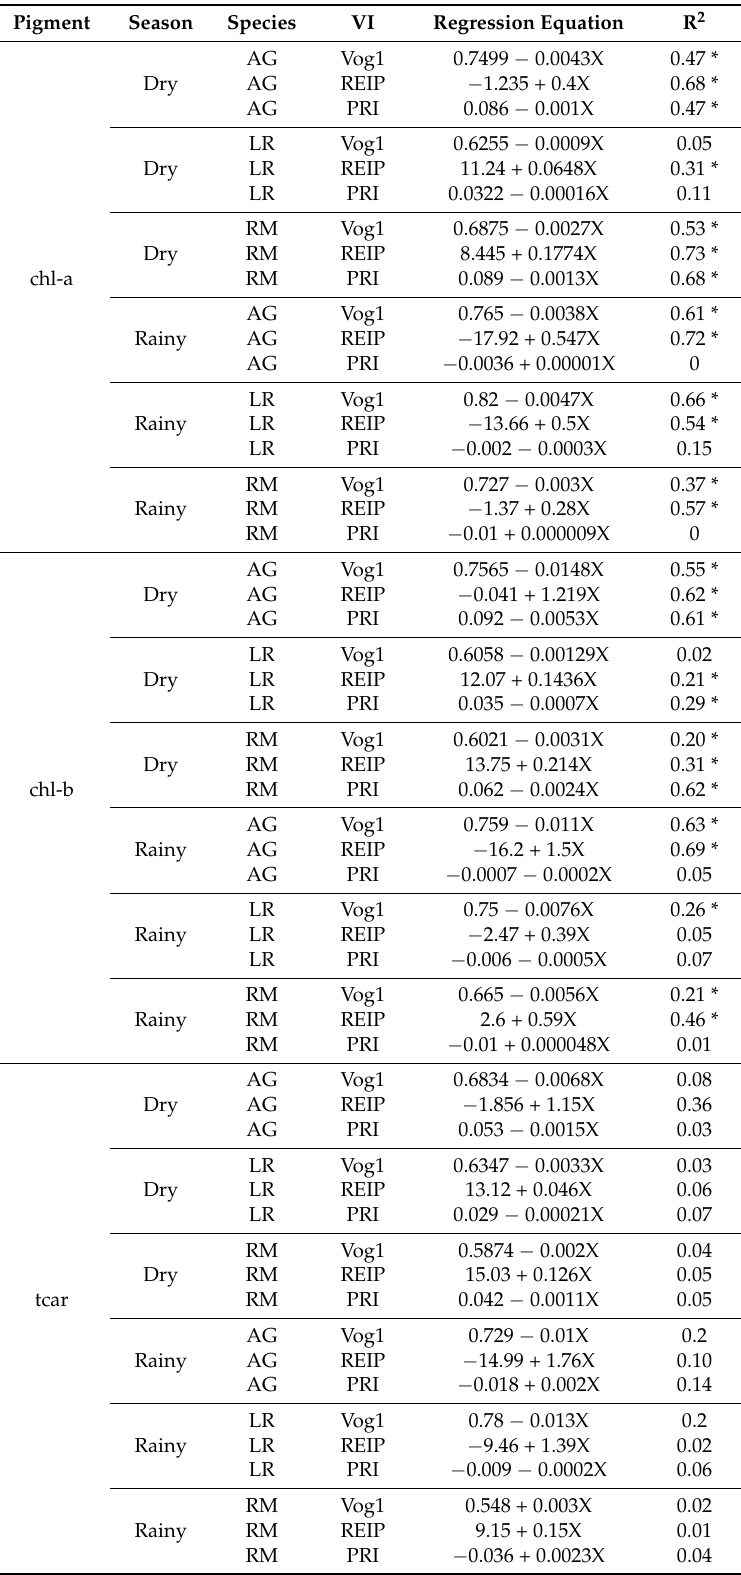
Table 4. Regression analysis of vegetation indices with leaf pigment chlorophyll-a, chlorophyll-b, and total carotenoids for the healthy mangrove classes. Avicennia germinans (AG), Laguncularia racemosa (LR), and Rhizophora mangle (RM). * Critical F -observed value at 4.1 ( α =